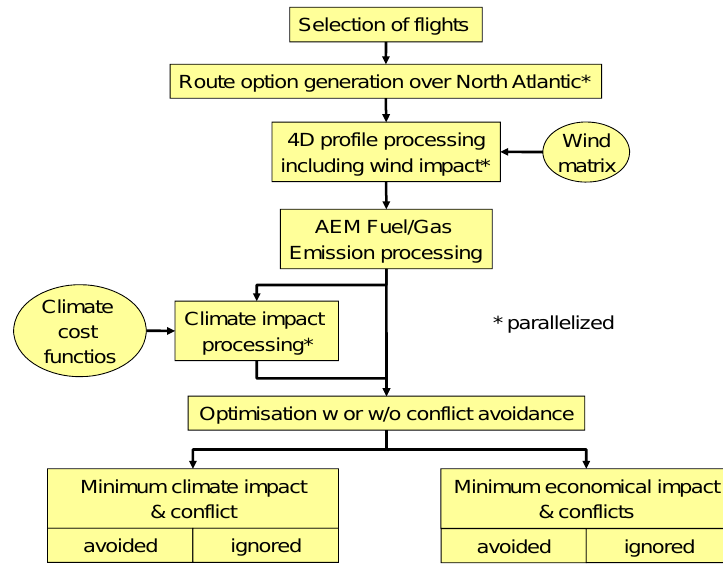
Fig. 2. Illustration of the SAAM and AEM model interaction.